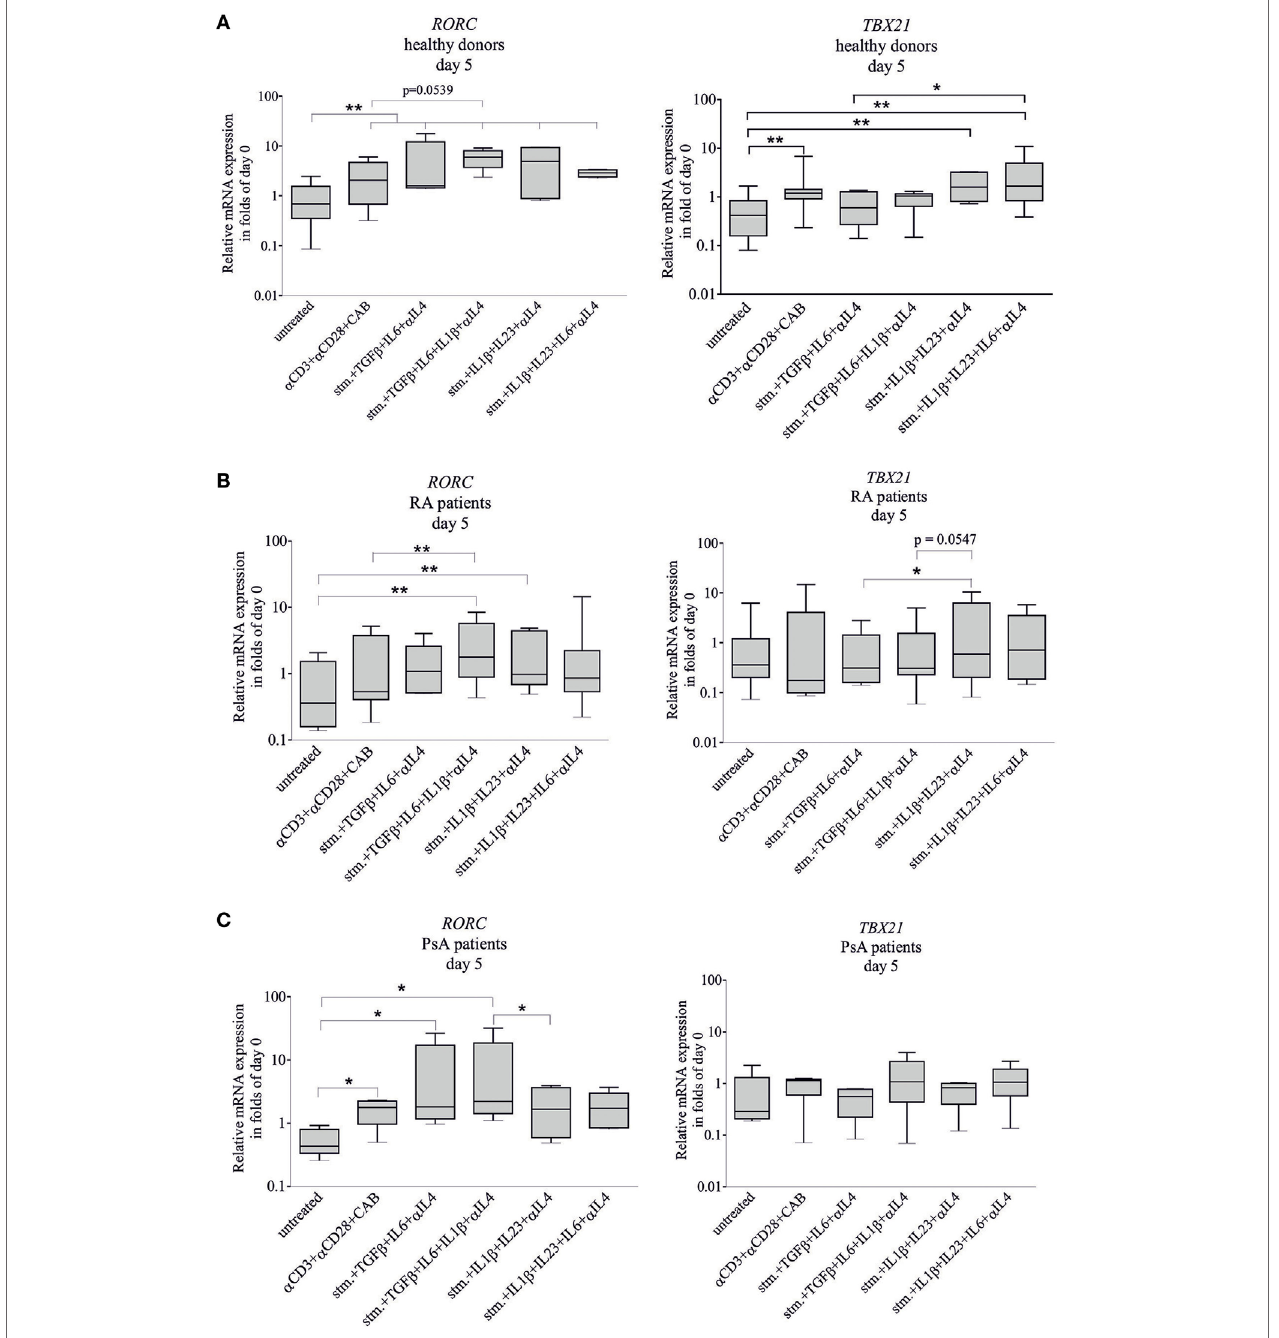
FigUre 4 | RORC and TBX21 expression during T-helper 17 (Th17) differentiation. Naive CD4 + T cells were differentiated toward Th17-lane. Samples were treated with CD3/CD28/CAB (stim) or with stim + anti-IL4 antibody and the following four cytokine combinations to promote naive CD4 + T cell differentiation: transforming grow factor beta (TGF β ) + IL6, TGF β + IL6 + IL1 β , IL1 β + IL23, and IL1 β + IL23 + IL6. Total RNA was isolated and the gene expressions were measured by quantitative real-time PCR on the fifth day of the differentiation. RORC and TBX21 transcription factor expressions of cells derived from healthy donors [ (a) n = 10], rheumatoid arthritis (RA) [ (B) n = 10], and psoriatic arthritis (PsA) patients [ (c) n = 6] are shown in a logarithmic scale. Untreated naive cells served as controls. The median, minimum, and maximum values are indicated (Friedman test and pairwise Wilcoxon signed rank test * p < 0.05, ** p <